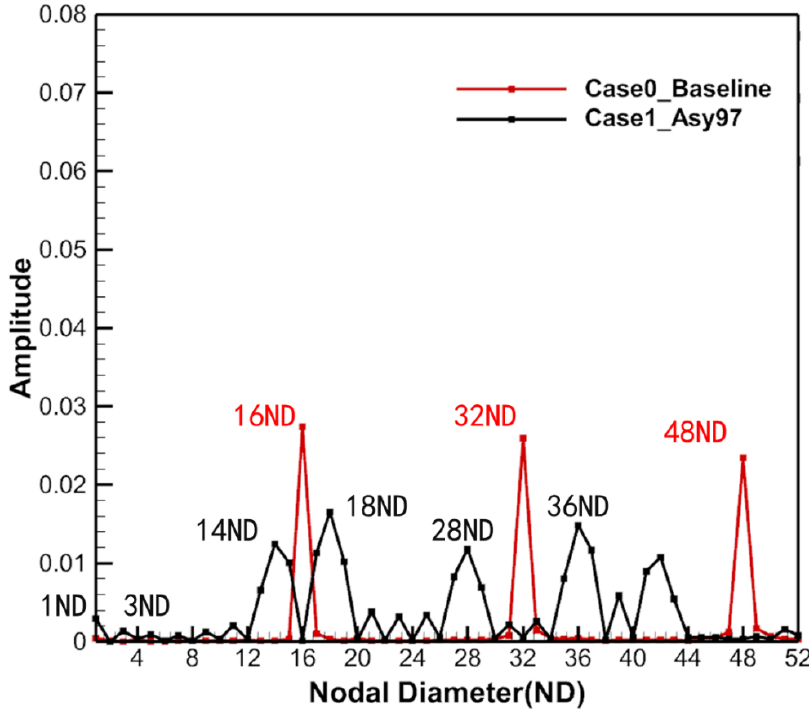
Figure 12. Spatial spectra of the midspan entropy wake at the vane exit.